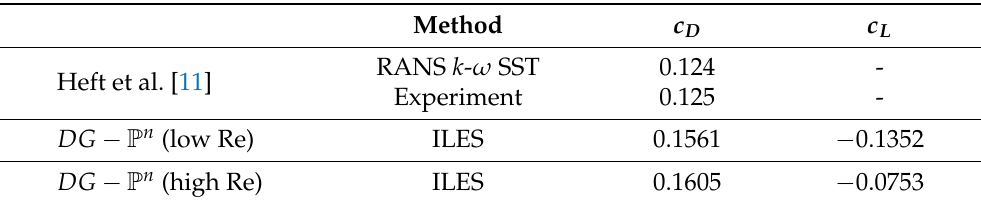
Figure 13. Simplified DrivAer model—Time-averaged pressure contours ( top-left ) and time- averaged pressure coefficient distribution on the windscreen ( top-right ), the front side window ( bottom-left ) and the back window ( bottom-right ), low-Reynolds number. Table 1. Simplified DrivAer model—Predicted drag, c D , and downforce, c L , coefficients for low- and high-Reynolds number case. Results are compared with reference